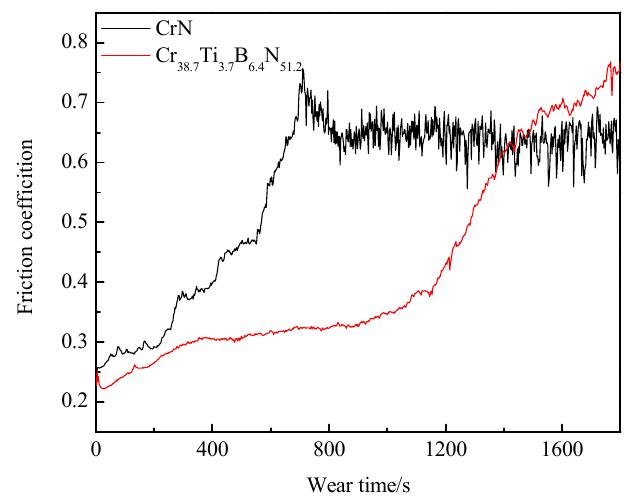
Figure 11. Friction curves of CrN film and Cr 38.7 Ti 3.7 B 6.4 N 51.2 composite film tested at 200 °C.